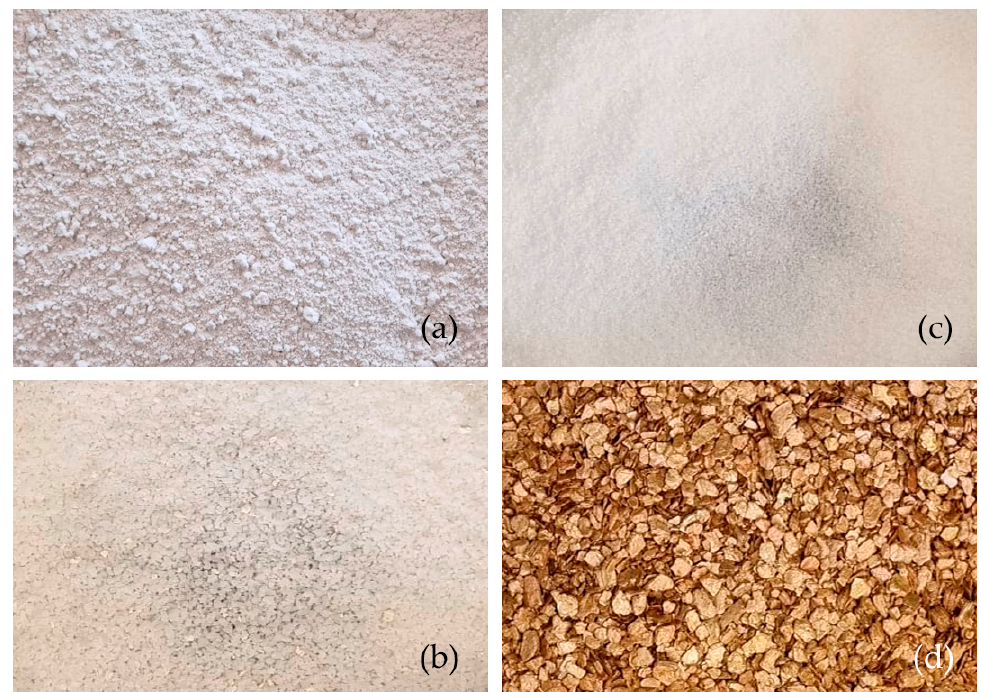
Figure 1. Materials used: ( a ) gypsum plaster; ( b ) potassium polyacrylate; ( c ) sodium polyacrylate; ( d ) vermiculite.